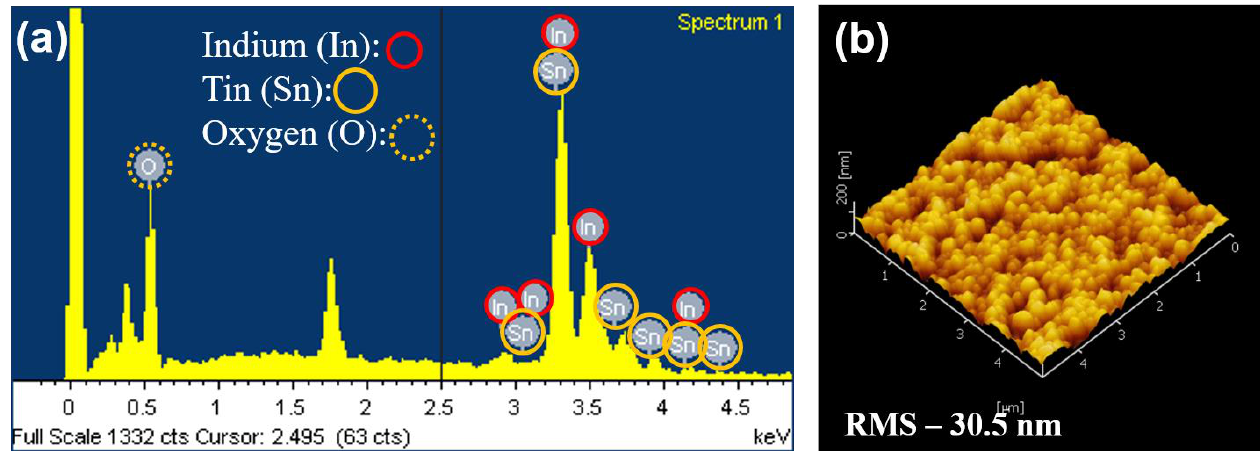
Figure 3. ( a ) EDS and ( b ) AFM images of ITO thin film.